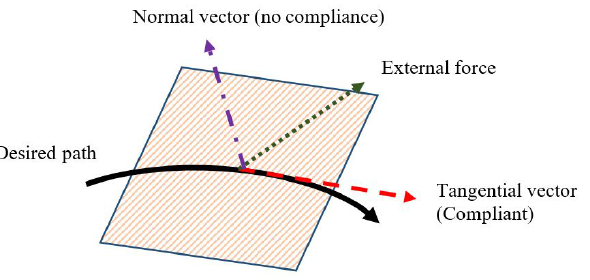
Figure 1. Path tracking for human–robot interaction with compliance along a predefined